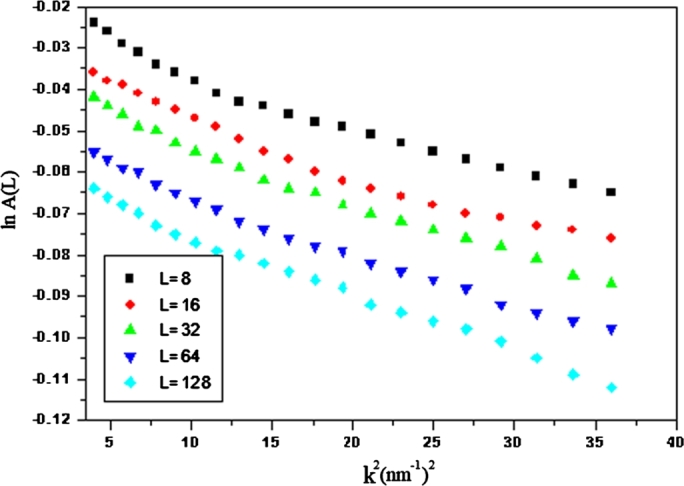
The relation between lnAL and k2 for THM crystal, according to classical Warren-Averbach equation.